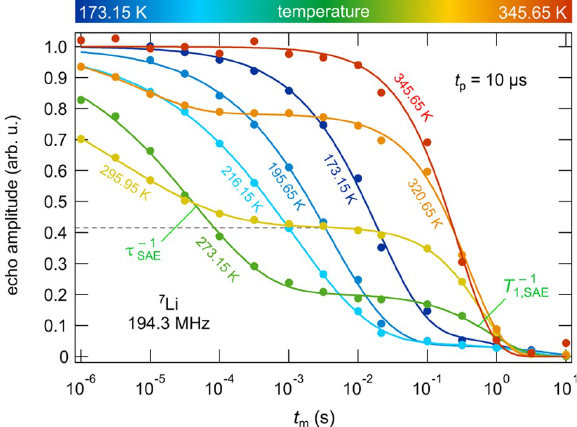
Figure 19. Two-time correlation functions measured from SAE experiments, showing two-step decay [63] .